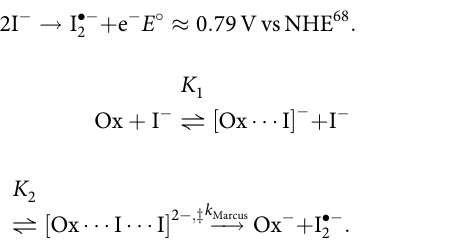
Figure 2c plots the log of k IET as a function of c A,X . A clear